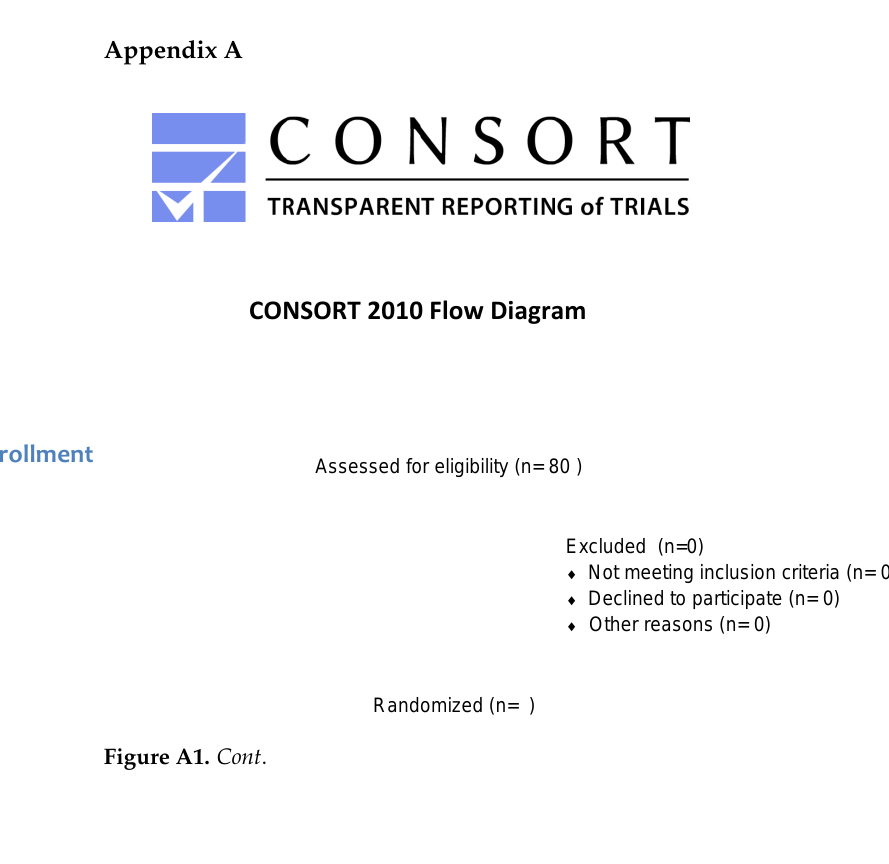
Figure A1. The CONSORT Flow Diagram. References 1.